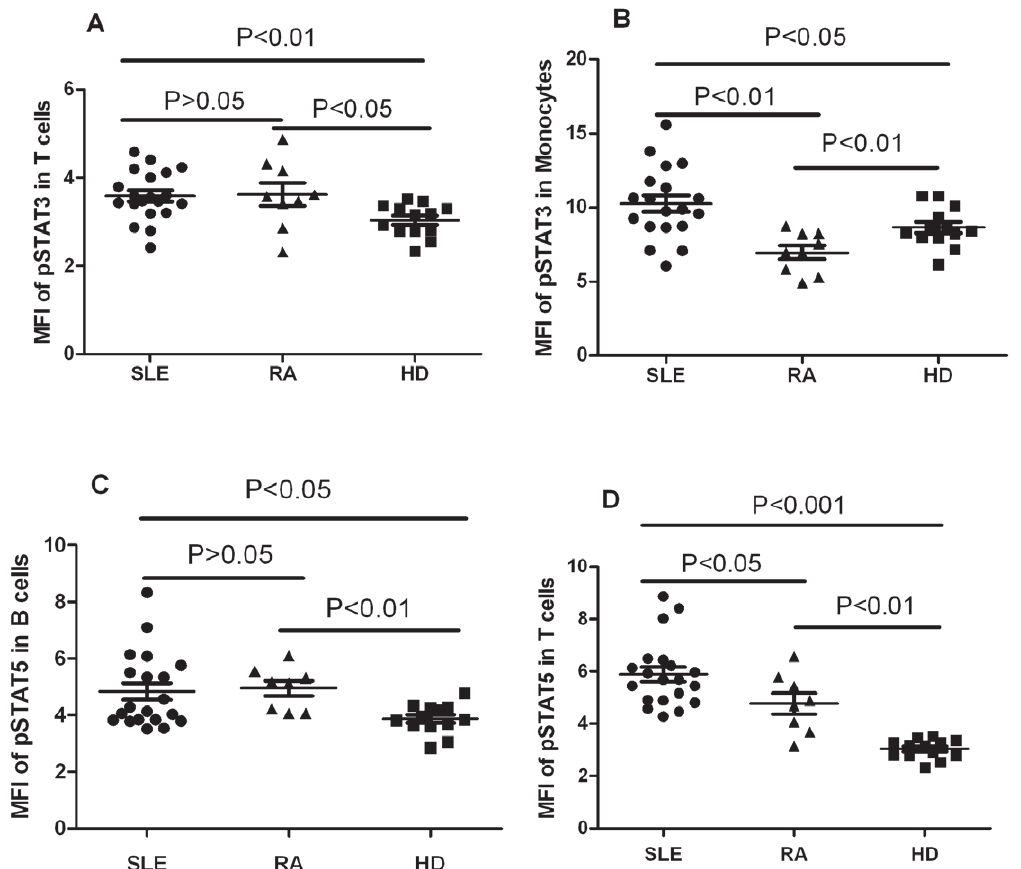
Figure 2. Comparison of pSTATs expression between SLE, RA patients and healthy donors (HDs). Each symbol represents an individual patient or HDs. (A) The MFI of pSTAT3 was elevated in the T cells of SLE, RA patients relative to that in HDs. (B) The MFI of pSTAT3 was elevated in the monocytes of SLE patients, but decreased in the monocytes of RA as compared with that in HDs. (C) The B cells of SLE patients, RA patients showed a higher MFI for pSTAT5 than that in HDs. (D) The T cells of SLE patients, RA patients showed a higher MFI for pSTAT5 than that in HDs. MFI, mean fluorescence index; SLE, systemic lupus erythematosus; RA, rheumatoid arthritis;HDs, healthy donors.